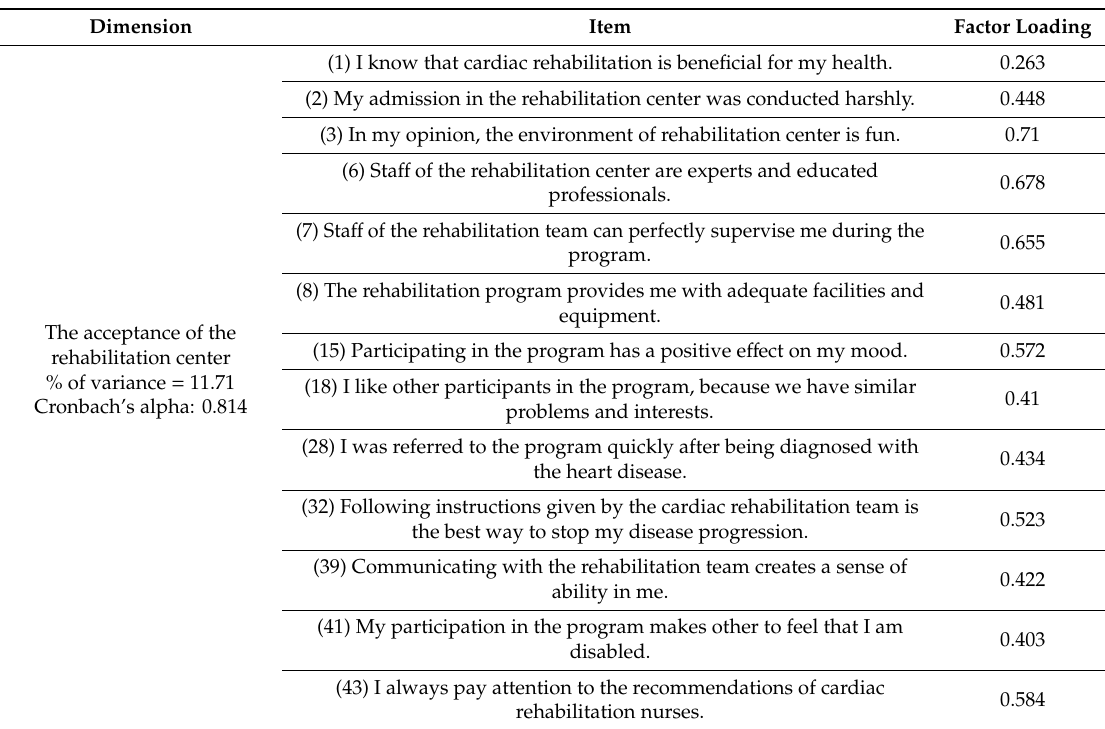
Table 3. Items, factor loadings, Cronbach’s alpha, and observed variances *. Dimension